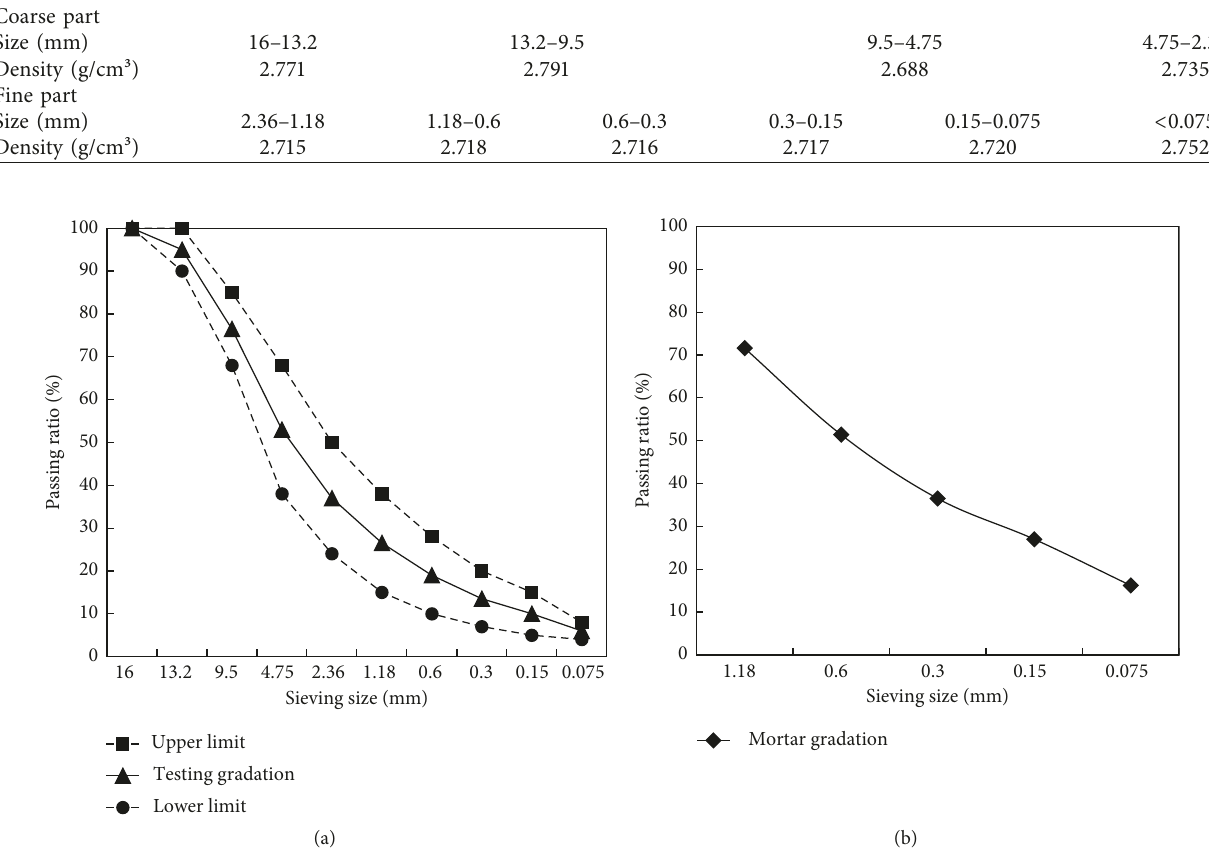
Figure 1: Testing gradations: (a) gradations for the asphalt mixtures; (b) gradations for the asphalt